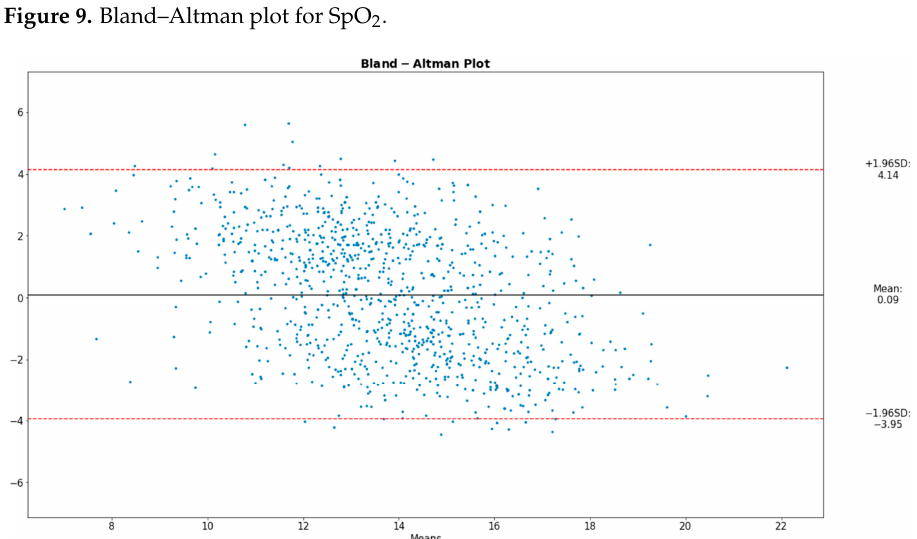
Figure 9. Bland–Altman plot for SpO 2 .